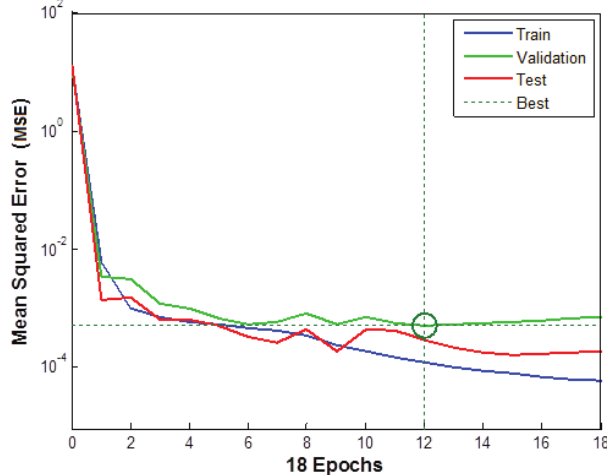
Fig. 6 – MSE for training, validation, and test dataset com- puted using LMB (with performance of 5·10 –4 at 12 Fig. 6 MSE for training, validation, and test dataset computed using LMB (with performance of epochs and goal of 1·10 –3 ) 5 · 10 -4 at 12 epochs and goal of 1 · 10 -3